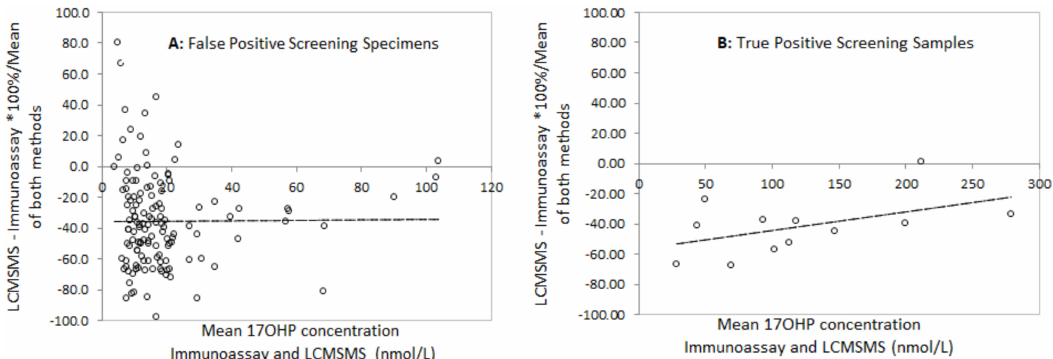
Figure 3. Bland Altman di ff erence plots for LCMSMS and Immunoassay after solvent extraction for A : False positive screening Tests and B : True Positive Screening tests, and for LCMSMS and Immunoassay for External quality assurance samples. A : Slope = 0.02 ( p = 0.89), mean di ff erence = − 35.7%, 2 sd limits of agreement (LOA) − 97.9% to + 26.4%); B : Slope = 0.13 ( p = 0.15), mean di ff erence = − 45.5%, LOA = − 90.7% to − 0.4%).